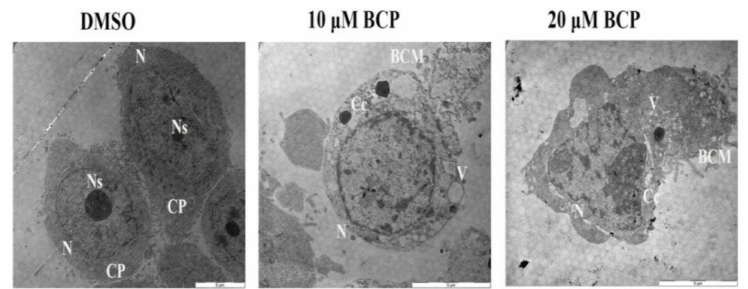
Figure 7. Ultrastructural micrographs using the TEM showing the apoptotic features of HCT 116 cells treated with BCP. HCT 116 cells treated with vehicle (0.5% DMSO) revealed intact cell membrane, normal cytoplasm (CP) with clear nucleus (N), and nucleolus (Ns). In contrast, BCP-treated cells revealed numerous cytoplasmic vacuoles (V), blebbing of the cell membrane (BCM), chromatin condensation (Cc), and disappearance of the nucleolus (Ns), suggesting the features of apoptotic cell death. The pictures were taken after 24 h treatment of vehicle or BCP at 1600 ×